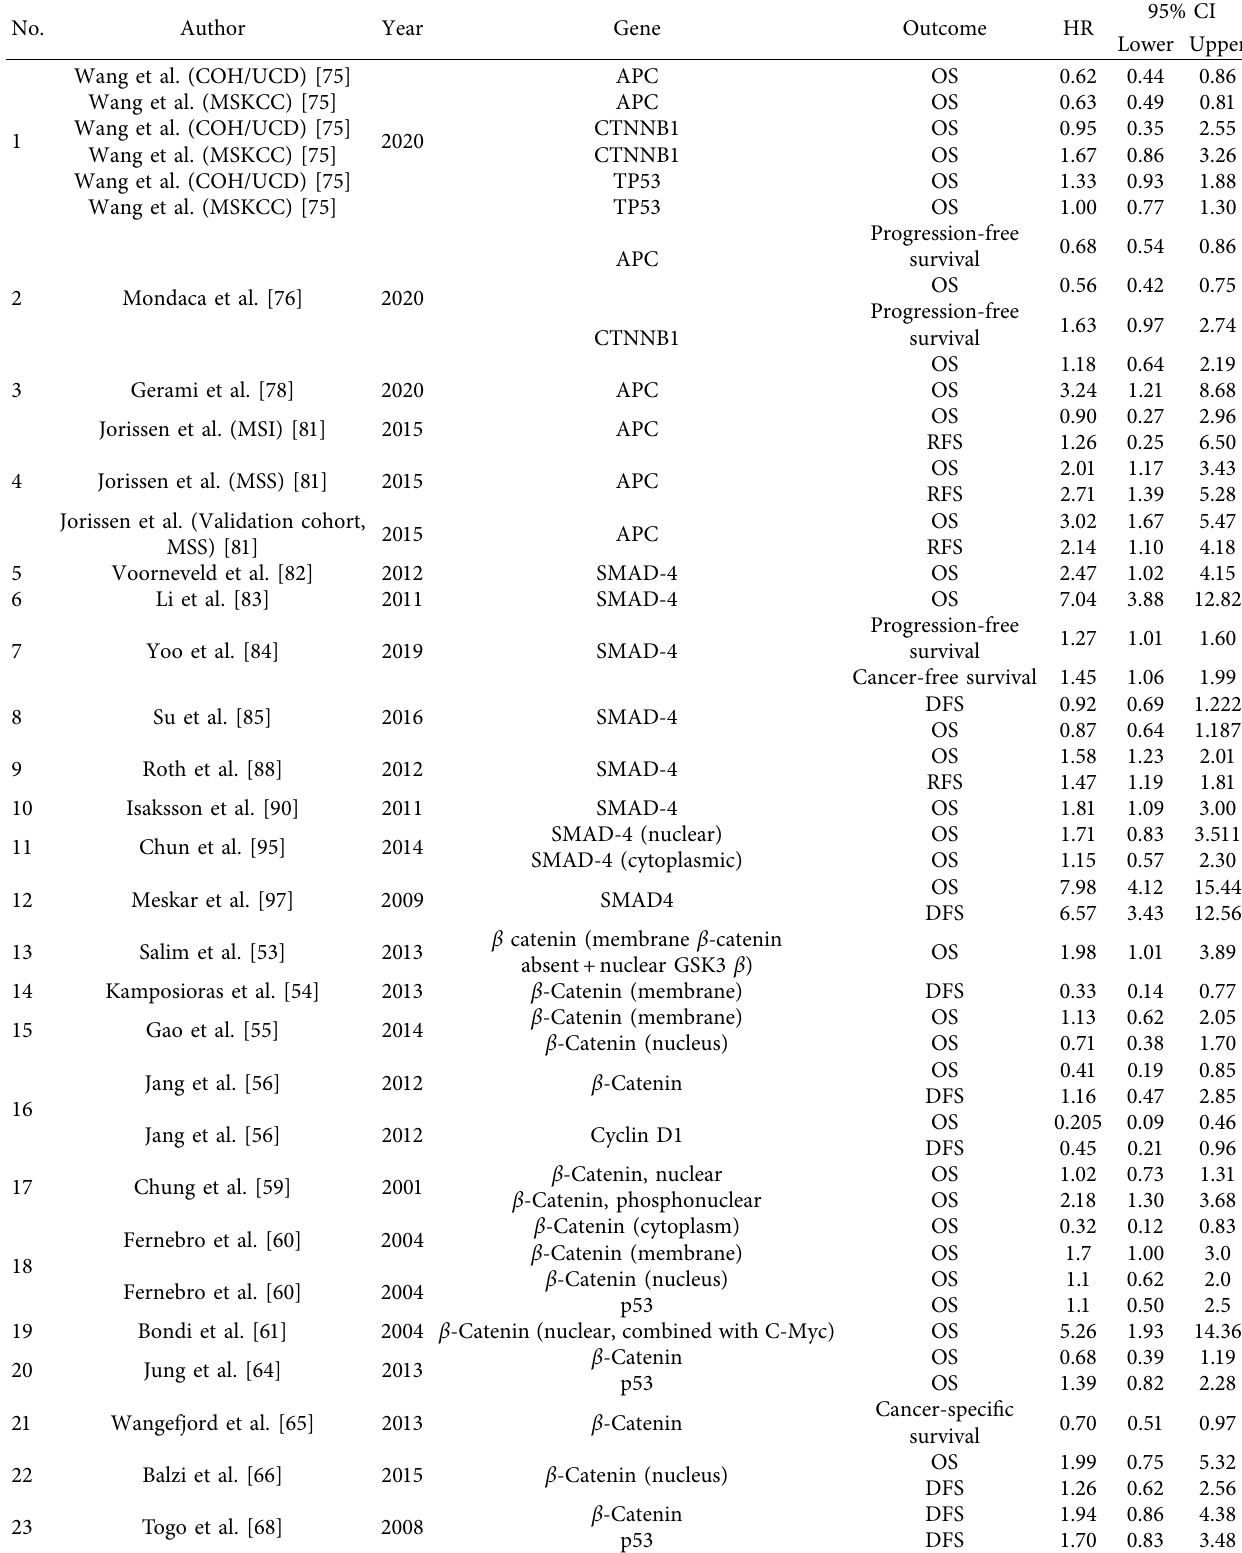
Table 2: Hazard ratios of studies included in